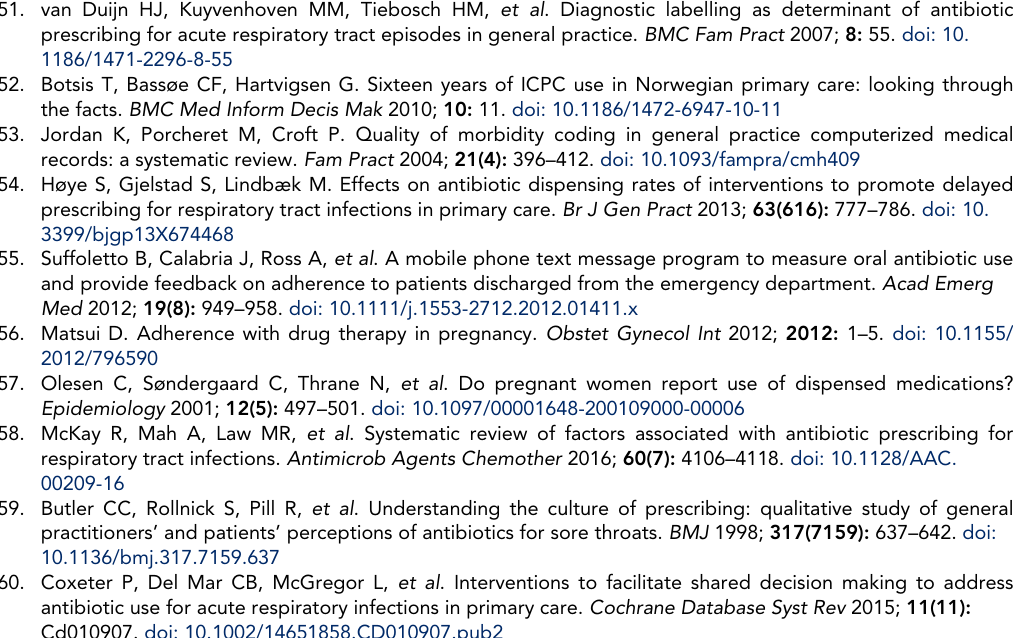
Fossum G Haugen et al . BJGP Open 2018; DOI: